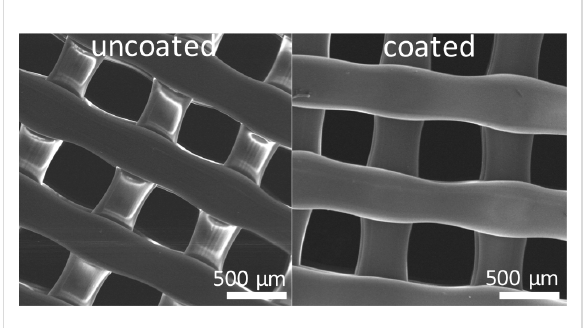
Figure 3: SEM images of the lattice before (left) and after (right) PPFDA coating.